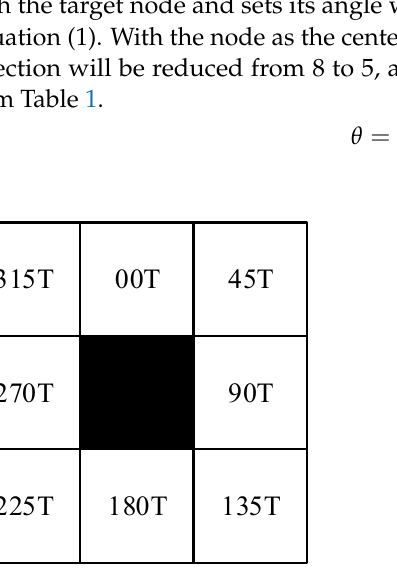
Figure 1. Node search direction. Table 1. Child node search direction strategy. Table 1. Child node search direction